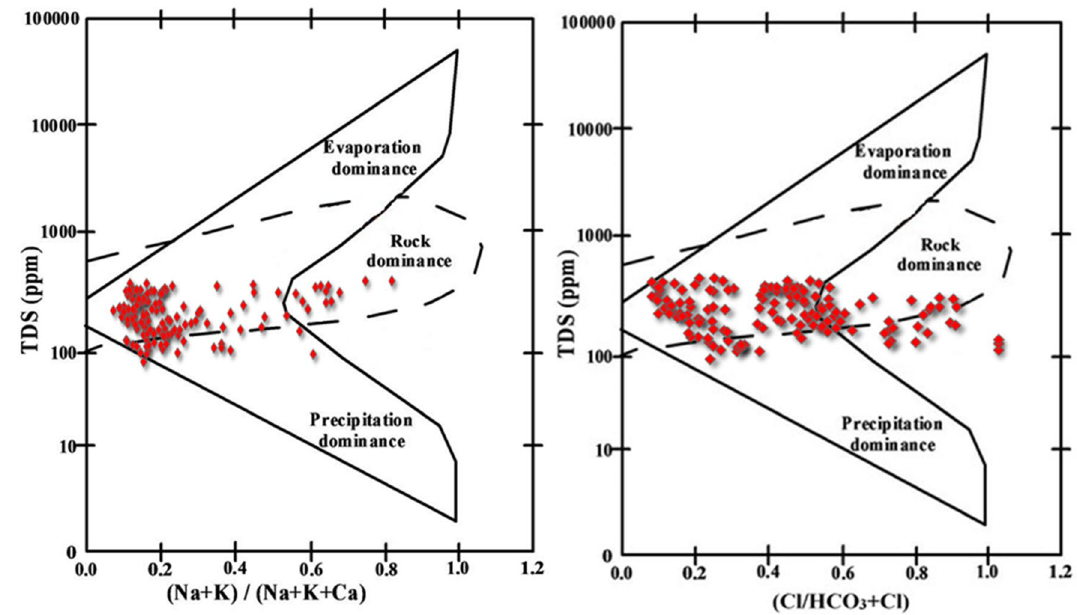
Figure 4. Gibbs diagram showing TDS vs Na + + K + /Na + + K + + Ca 2+ and Cl − /HCO 3 − + Cl − for evaluating factors controlling spring water chemistry. The figure was generated using Microsoft Excel 2016 (https:// suppo rt. micro soft. com/ en- us/